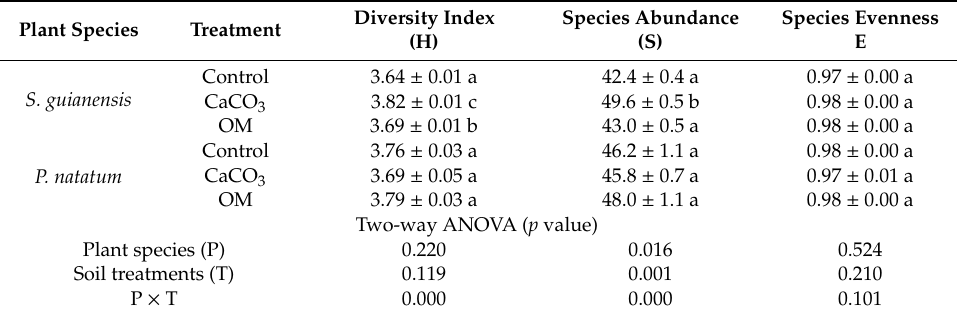
Table 3. Influences of liming (CaCO 3 ) and plant residue incorporation (OM) on bacterial community structure in the soil of S. guianensis and P. natatum . Data followed by the same letter are not significantly different for each plant species (Tukey’s post hoc test, P = 0.05, n = 5).